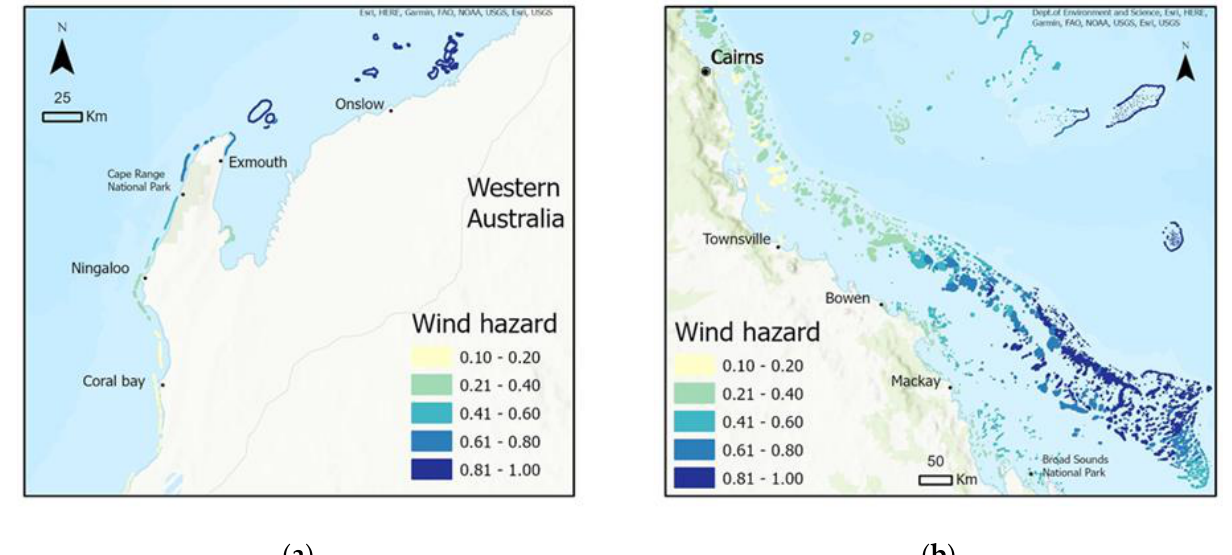
Figure 4. Tropical Cyclone wind hazard to corals in the Ningaloo Reef ( a ) and the southern Great Barrier Reef ( b ). Higher (darker) values denote higher 0.2 sec cyclonic wind gusts modelled for the 100-year return period.